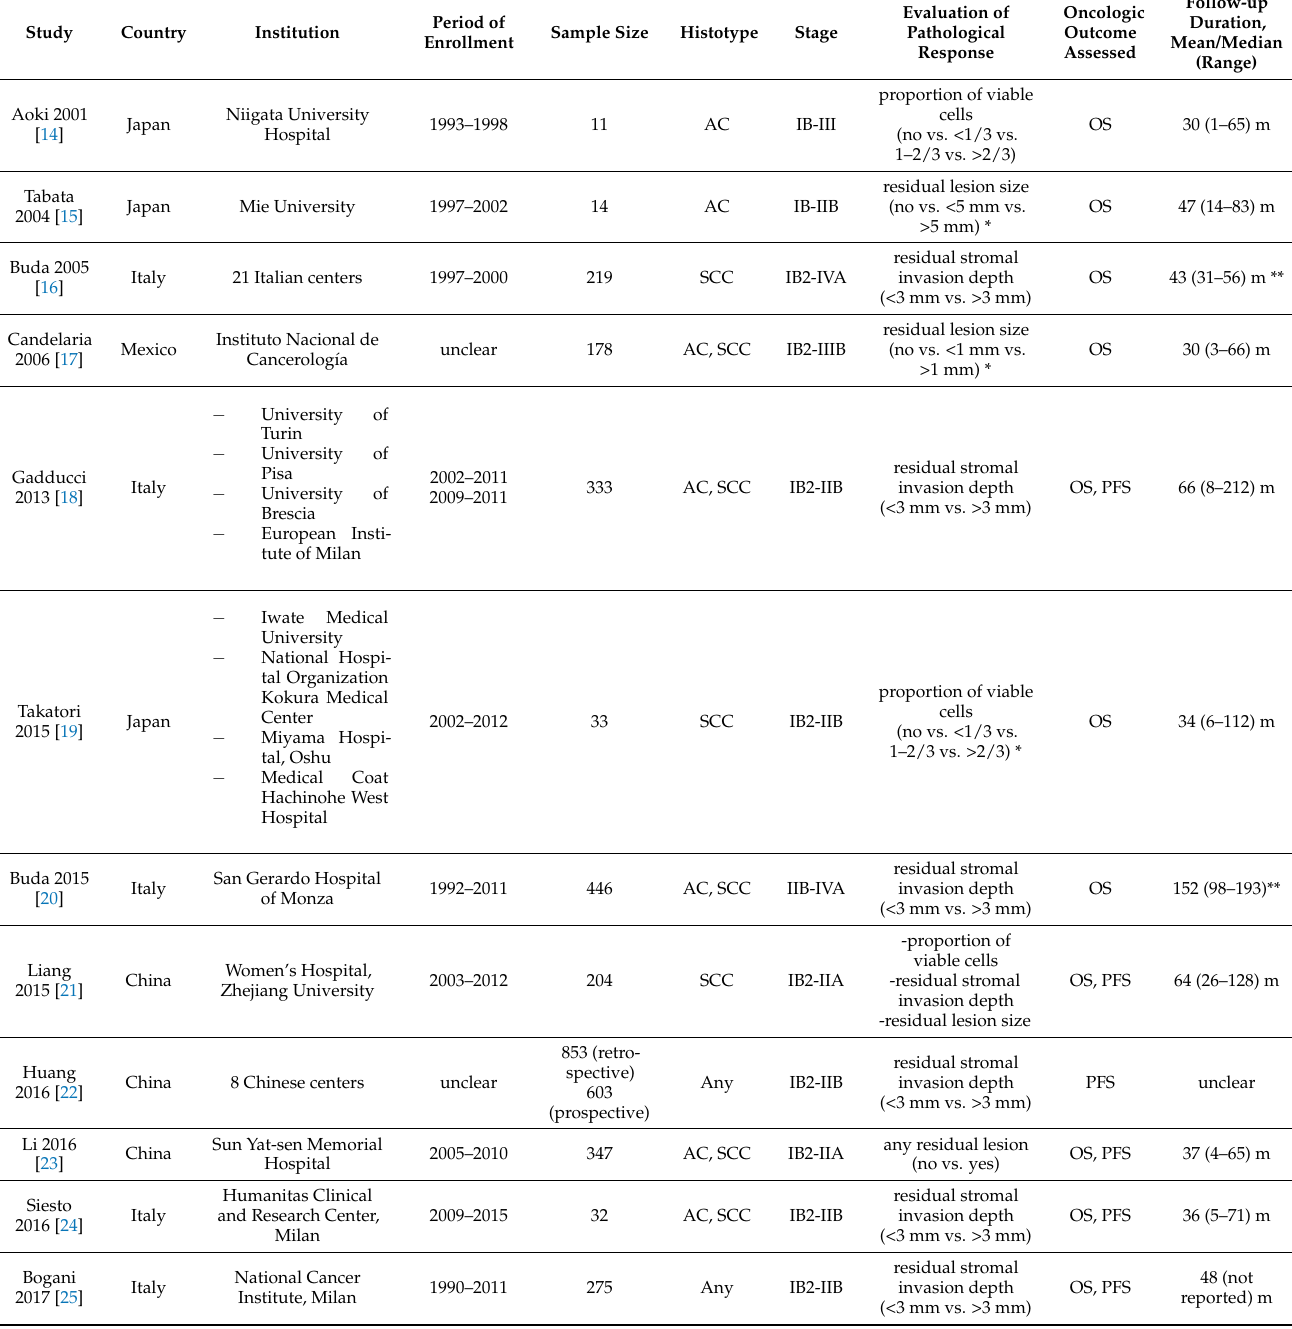
Table 1. Characteristics of the included studies. *: Available data for complete disappearance vs. any residual. **: 25th and 75th percentile are reported instead of